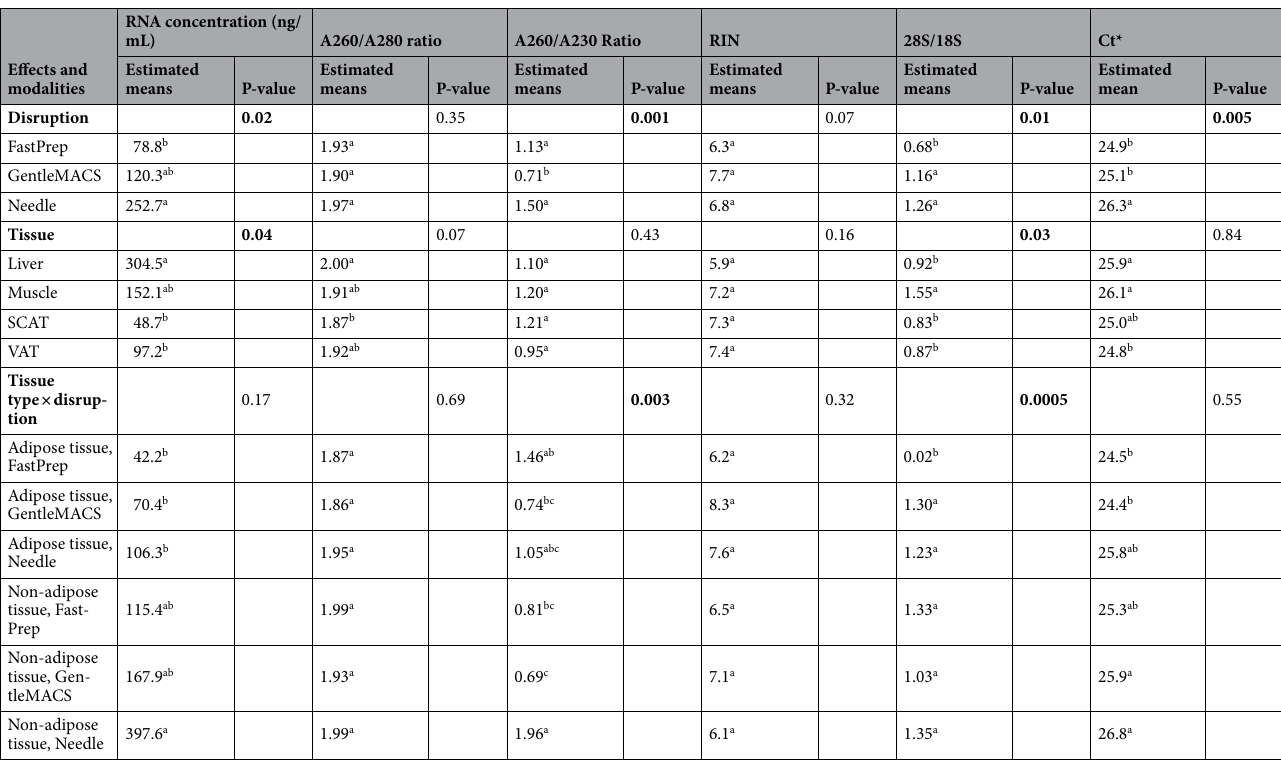
Table 1. Estimated least-square means from ANOVA models of RNA quality parameters and RT-qPCR results. The letters indicate significant changes in means (numbers with the same letters are not different). P-value <0.05 are shown in bold. FastPrep for FastPrep Instrument, GentleMACS for GentleMACS Dissociator, Needle for syringe/needle. *The effects Gene, Gene × Tissue Type, Gene × Disruption and Gene × Disruption × Tissue Type were included in the model. Results are available in Supplementary Table